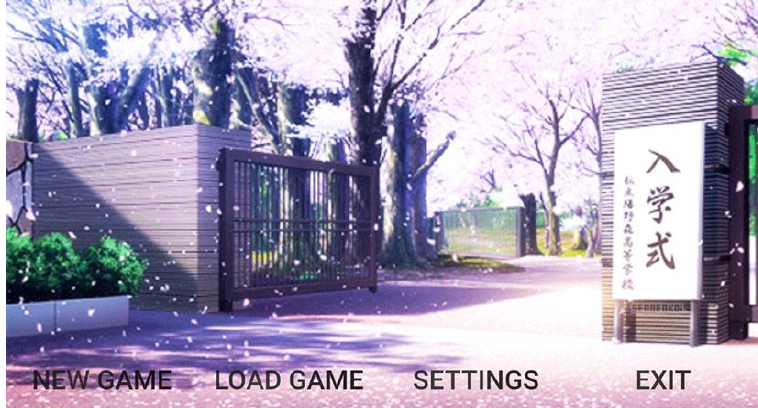
Picture 2. Tittle screen of the